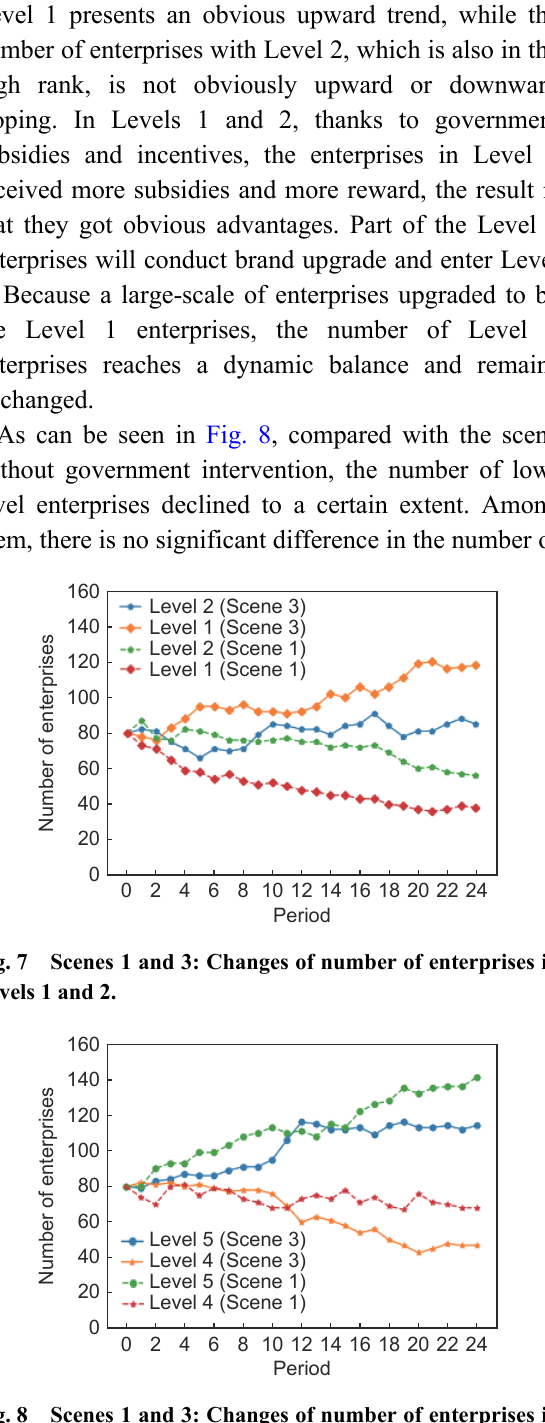
Fig. 6 Scenes 1 and 3: Changes of number of low-, middle-, and high-level enterprises.